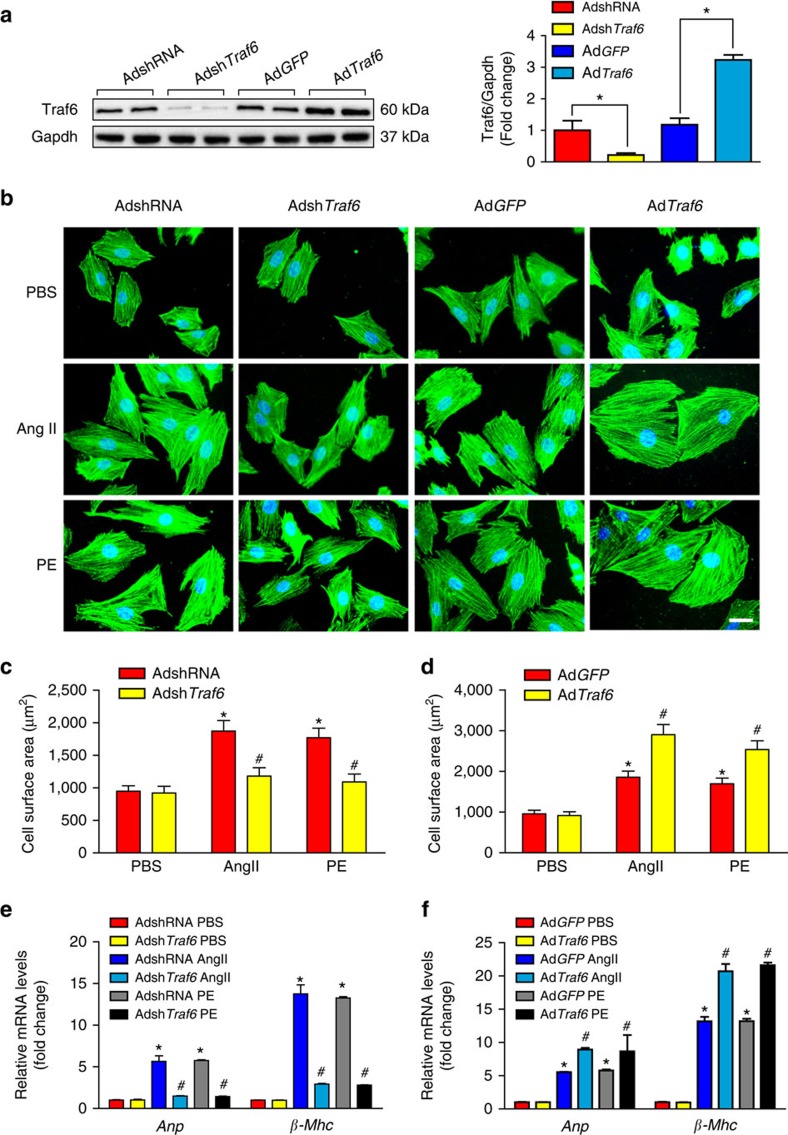
Traf6 promotes Ang II/PE-induced cardiomyocyte hypertrophy in vitro.(a) Primary cardiomyocytes were infected with AdshRNA, AdshTraf6, AdGFP or AdTraf6 for 24 h. Cells were then harvested, and cellular lysates were analysed by western blotting to measure Traf6 expression levels (*P<0.05 versus AdshRNA or AdGFP). (b) Representative microscopic images of cardiomyocytes infected with the indicated adenoviruses and treated with PBS, Ang II or PE for 48 h. Cardiomyocytes were identified by α-actinin staining (green), and nuclei were stained with DAPI (blue). Scale bars, 20 μm. (c,d) Quantitative results of the cell surface area of cardiomyocytes infected with AdshTraf6 or AdTraf6 as well as their AdshRNA or AdGFP controls in response to PBS, Ang II or PE for 48 h (n>50 cells/group, *P<0.05 versus AdshRNA PBS or AdGFP PBS, #P<0.05 versus AdshRNA Ang II/PE or AdGFP Ang II/PE). (e,f) Real-time quantitative PCR was performed to determine the transcriptional levels of Anp and β-Mhc in adenovirus-infected cardiomyocytes after treatment with PBS, Ang II or PE for 48 h (*P<0.05 versus AdshRNA PBS or AdGFP PBS, #P<0.05 versus AdshRNA Ang II/PE or AdGFP Ang II/PE). Data are presented as the mean±s.d. from at least three independent experiments. Statistical analysis was carried out by one-way ANOVA.